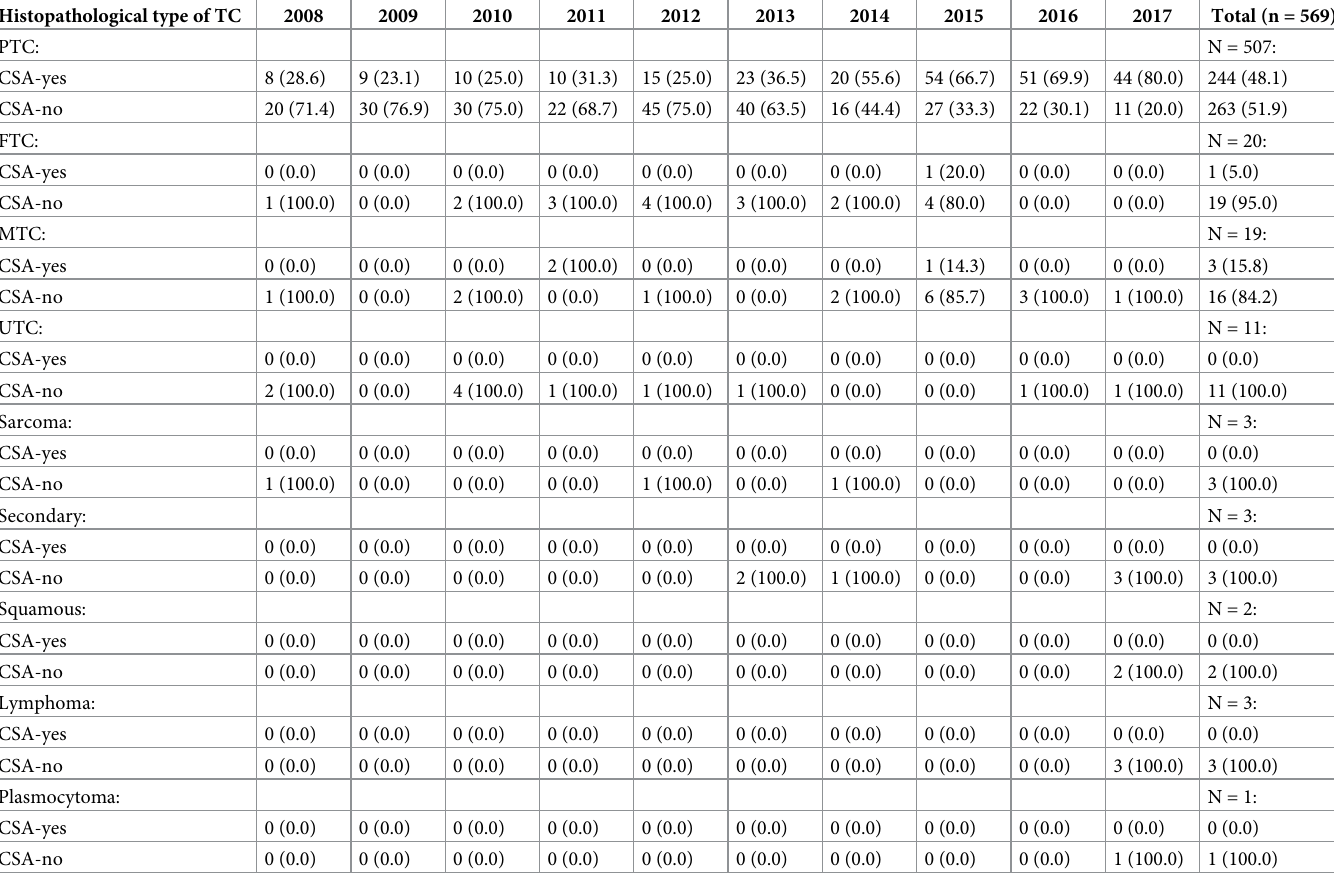
Table 2. Comparison of the histopathological types of thyroid cancer and cancer screening activity in thyroid cancer patients from 2008–2017. Descriptive data are presented as numbers (percentages). Histopathological type of